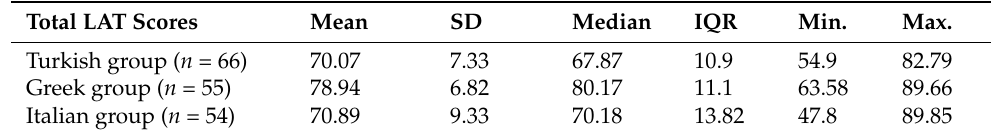
Figure 4. Total LAT scores across the language groups. Interestingly, the Italian group displayed the highest overall range and highest in- When comparing the scores in L1 and L2 across the different language groups, an terquartile range, while their mean score was very similar to that of the Turkish group. even more differentiated picture emerged (cf. Figure 5). The scores of students in the Turkish group, however, had a similar interquartile range to the Greek group, which means that the statistical variance within these groups was more homogenous. Moreover, in the Greek group, the total range was smaller than in the other groups (cf. Table 3). Table 3. Total LAT scores across the different language